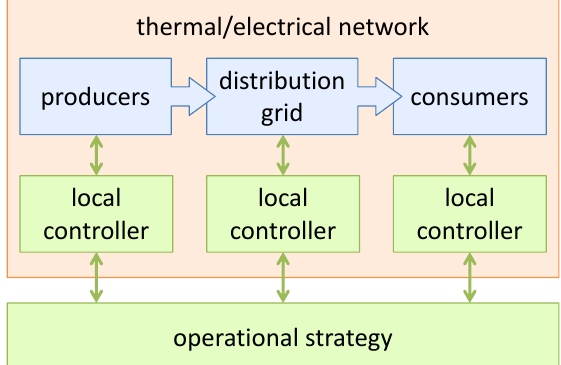
Figure 2. Overview of local control (process level) versus operational strategy (system